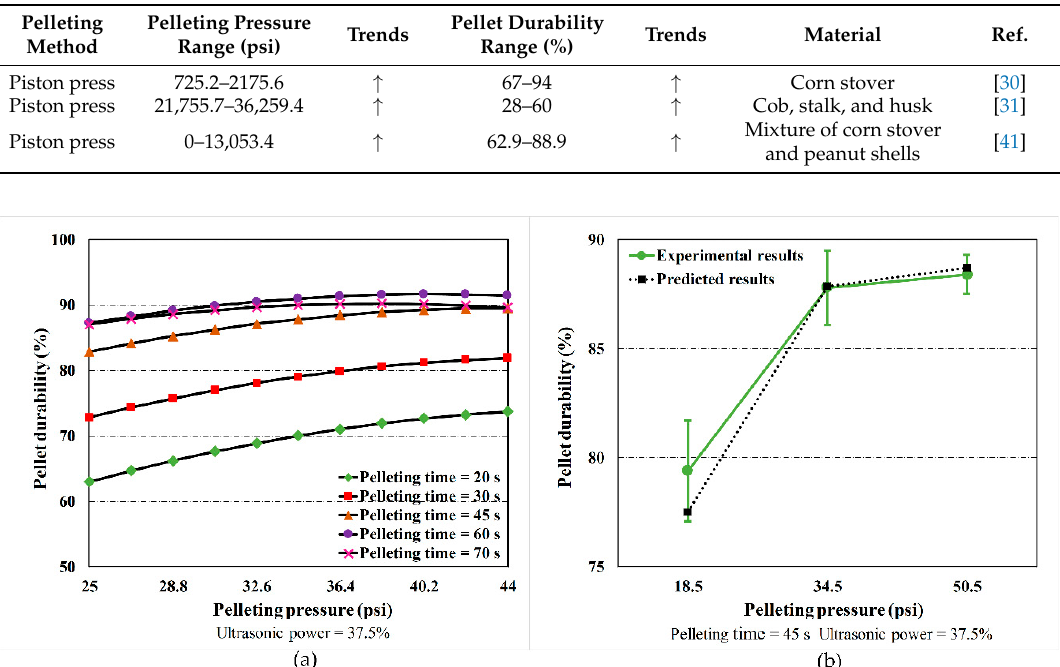
Figure 6. The effects of ultrasonic power on pellet durability. ( a ) The predicted pellet durability in relation to ultrasonic power at different levels of pelleting pressure (ranging from 17 psi to 50 psi) when the pelleting time was set to 45 s and the ultrasonic power increased from 25% to 50%. ( b ) For pellet durability, the comparison between the model results and experimental results at various levels of ultrasonic power (mean value ± SD). Table 7. The effects of pelleting pressure on pellet durability by using other pelleting methods.